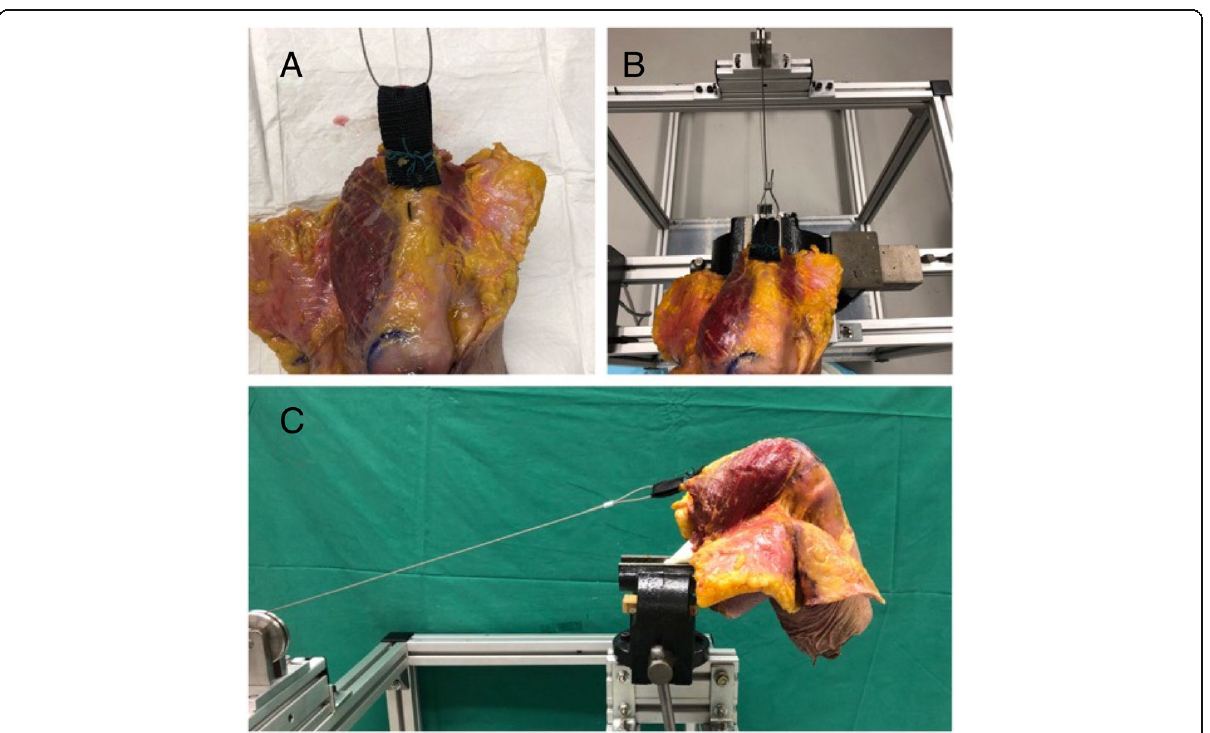
Fig. 2 A – Nylon band attached the quadriceps tendon B – Cable attached to nylon band C - Femur mounted onto jig with cable running through pulley